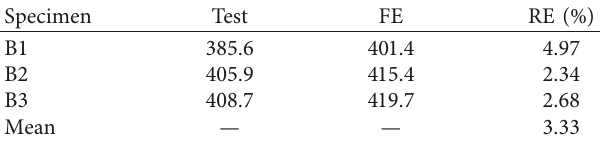
Table 2: Ultimate load (kN).